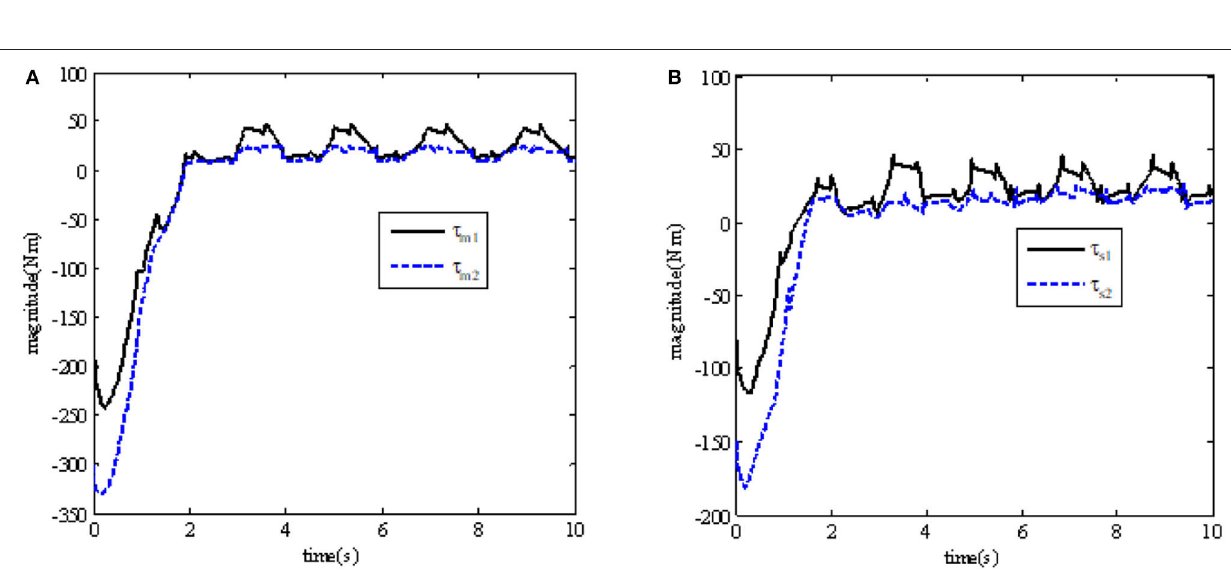
FIGURE 3 | Input torque τ m and τ s of robot joints. (A) The master robot joint input torque τ m ; (B) the slave robot joint input torque τ s .